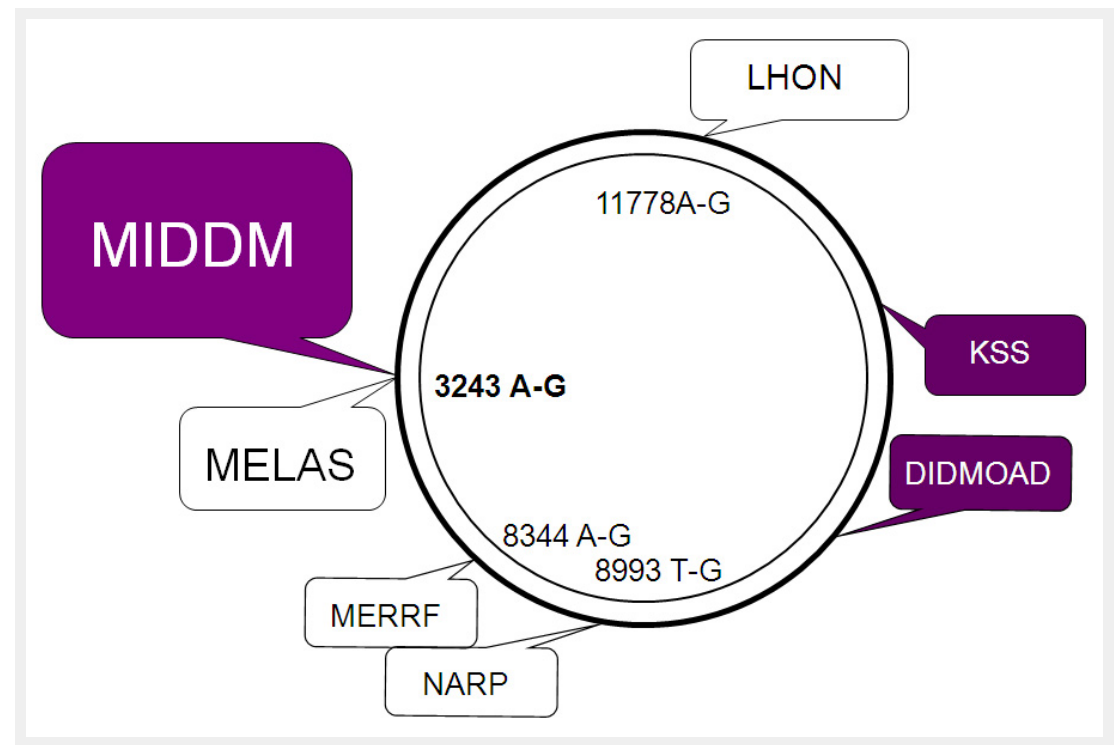
Figure 3 Mitochondrial DNA schematically depicted as circular double-strand DNA with some mutation syndromes. MIDDM = maternally inherited deafness and diabetes mellitus; MELAS = mitochondrial encephalomyopathy, lactic azidosis and stroke-like episodes; DIDMOAD = diabetes insipidus, diabetes mellitus, optic atrophy, and deafness; KSS = Kearns-Sayre syndrome; LHON = Leber‘s hereditary optic neuropathy; MERRF = myoclonic epilepsy, ragged-red fibers; NARP = neuropathy, ataxia, and retinitis